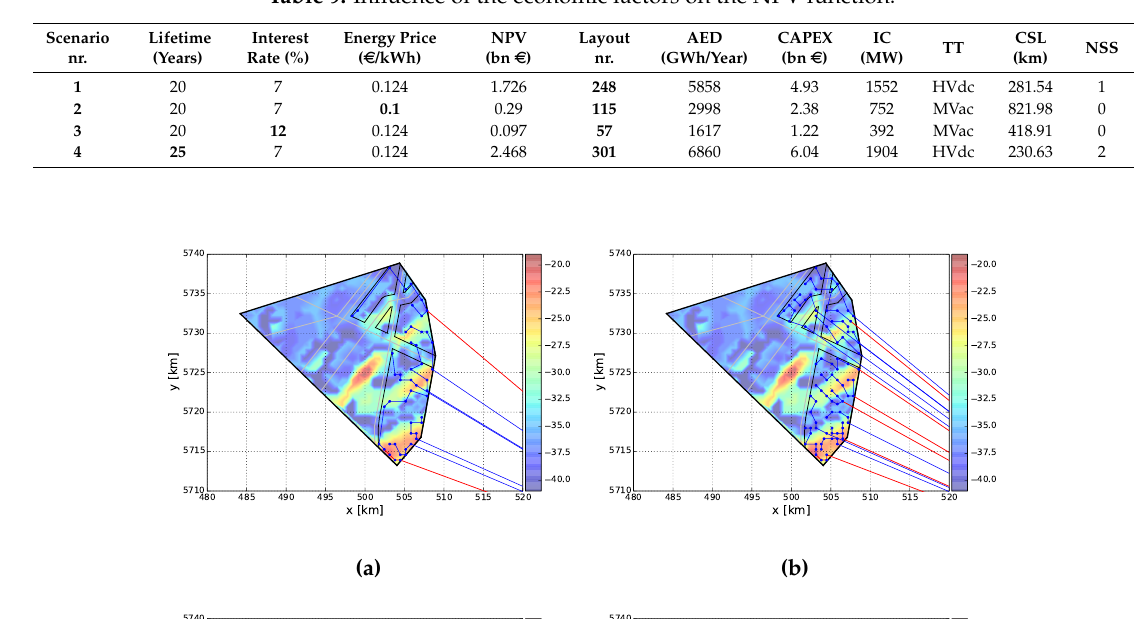
Table 9. Influence of the economic factors on the NPV function.